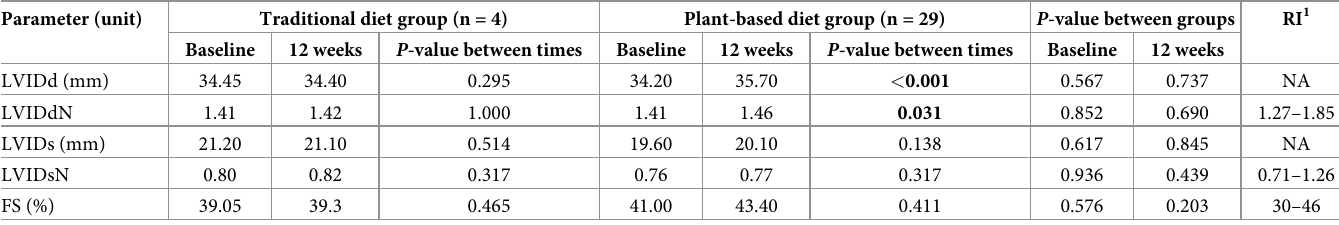
Table 3. Left ventricular echocardiographic findings in dogs receiving a traditional diet or a plant-based diet for 12 weeks. Parameter